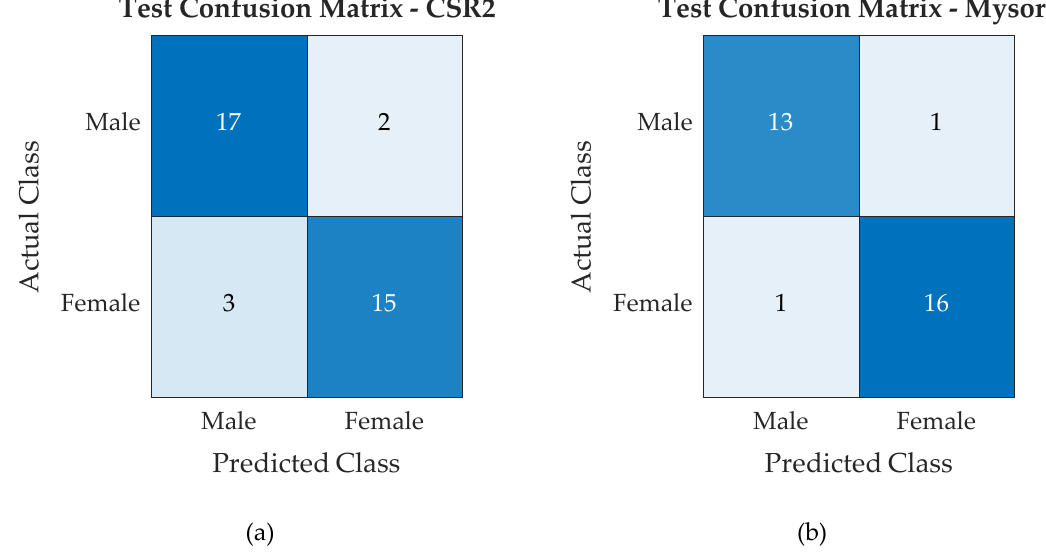
Figure 14. SVM test confusion matrix for CSR2 cocoons ( a ) and Pure Mysore cocoons ( b ).